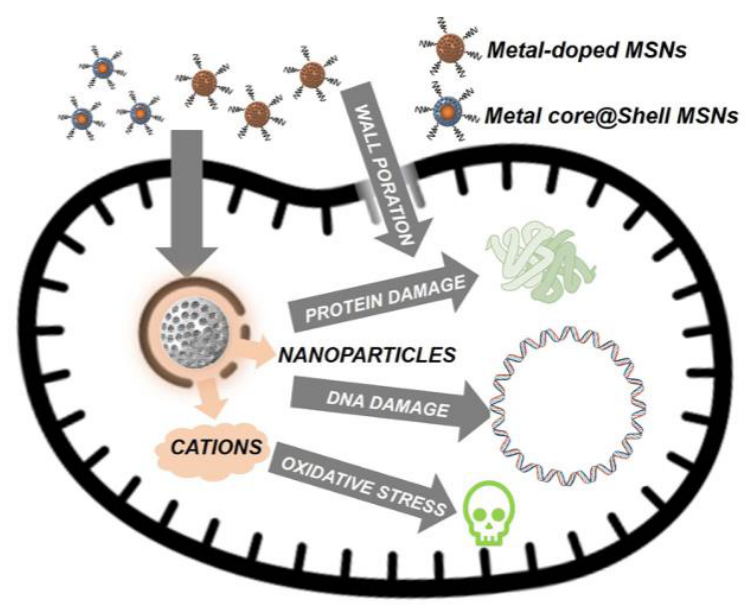
Figure 4. The mechanism of the action of the silicon nanocarrier delivering antibacterial material towards bacteria [23]. Creative Common Attribution—Non-Commercial (unported, v3.0). Licence (http://creativecommon.org/licenses/by-nc/3.0/, accessed on 1 August